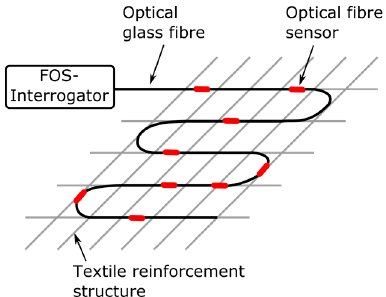
Figure 1. Sketch of a textile reinforcement structure that is functionalized with fiber optic sensors in order to monitor important SHM parameters. The textile reinforcement structures are designed so that they can act as both sensing and strengthening mechanism.